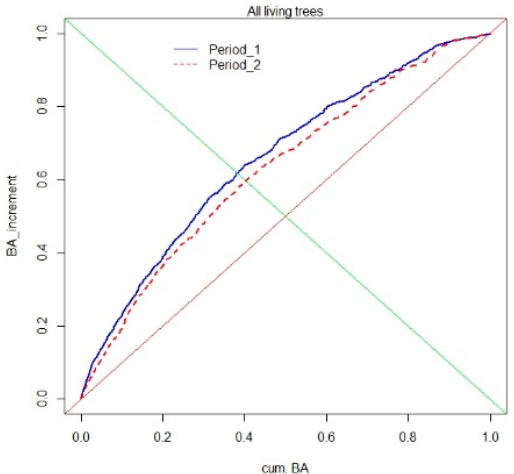
Figure 12. Growth dominance curves for the multispecies, uneven-aged forest, calculated for the basal area (BA) of all trees in both periods of observation.